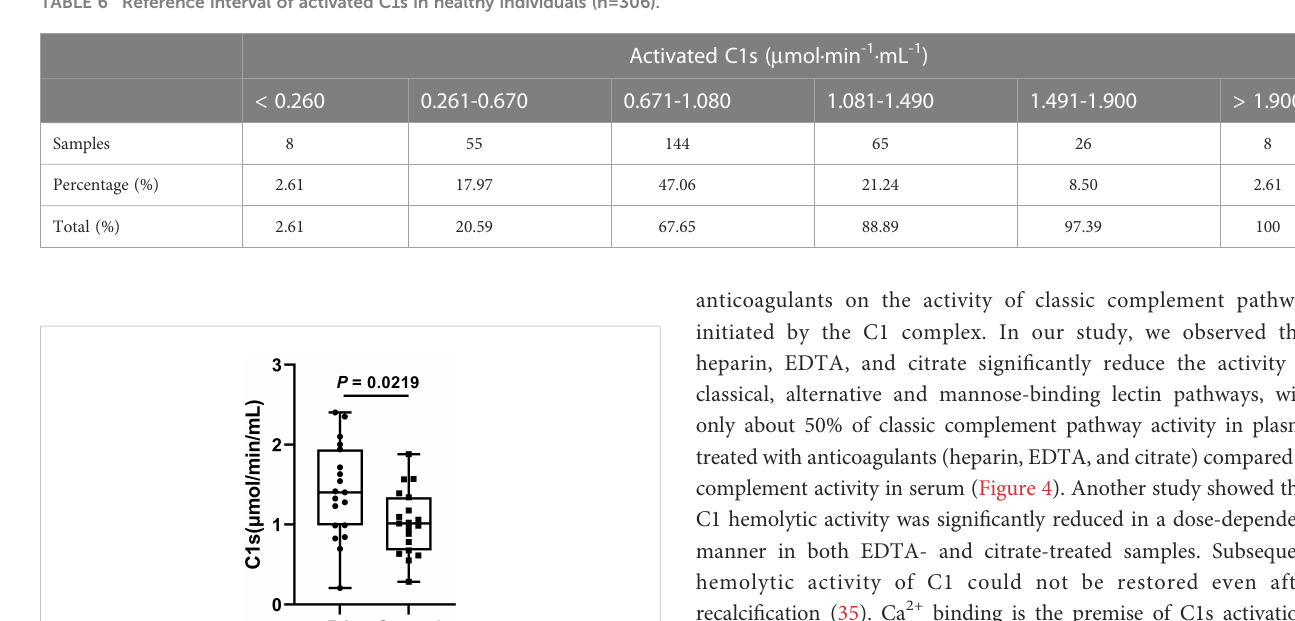
TABLE 6 Reference interval of activated C1s in healthy individuals (n=306).